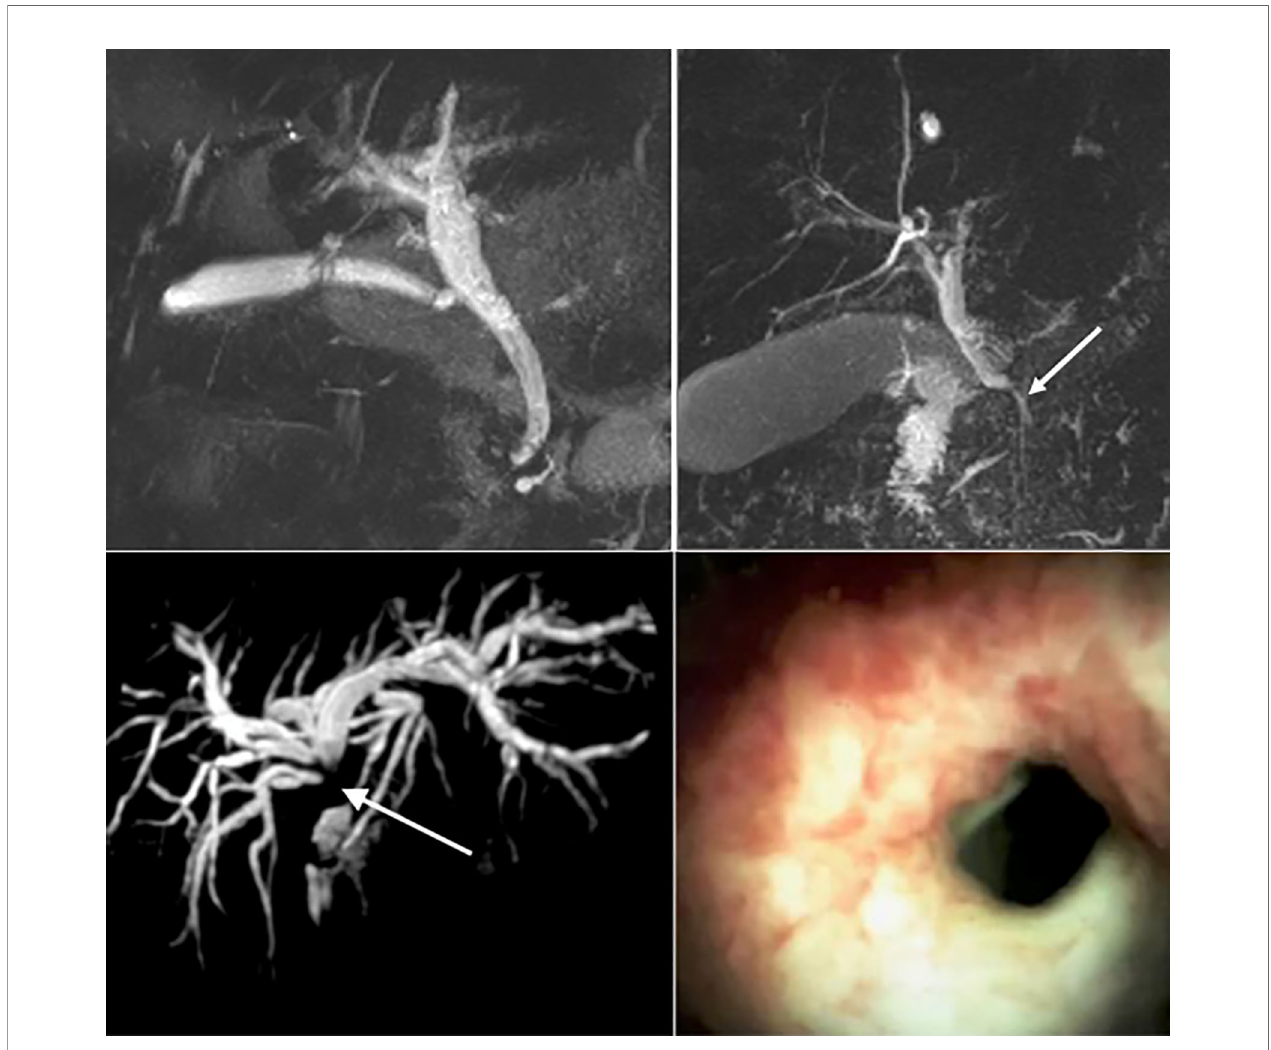
FIGURE 3 | Top left: Magnetic resonance imaging (MRI) of a normal biliary tree. Top right: MRI imaging of a benign biliary stricture secondary to acute pancreatitis (white arrow). Bottom Left: MRI of a dilated intrahepatic biliary tree secondary to a cholangiocarcinoma at the liver hilum (white arrow). Bottom right: Cholangioscopy demonstrating mucosal nodularity and neovascularisation in the 7 -o ’ clock position, secondary to